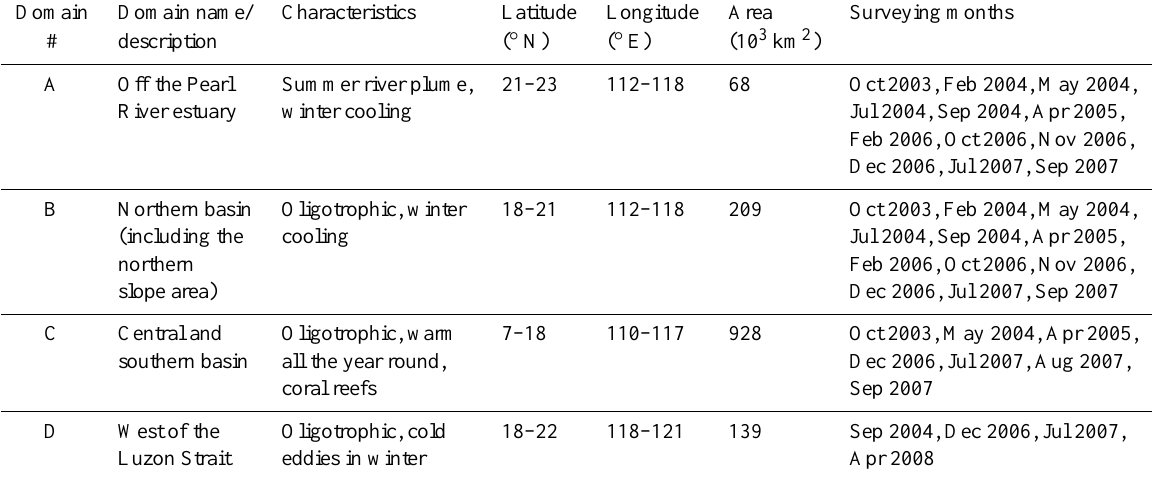
Table 1. Physical–biogeochemical domains in the South China Sea categorized in the present study.